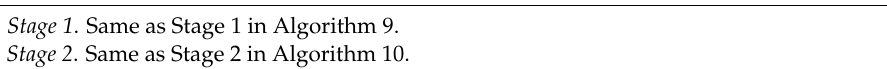
Algorithm 11: For the advection–diffusion-reaction